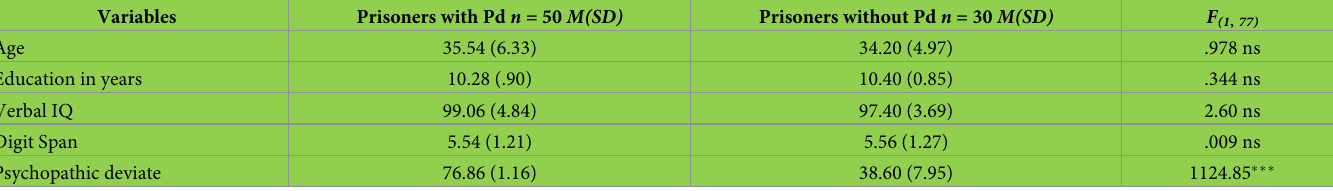
Table 1. Demographic and intellectual characteristics.